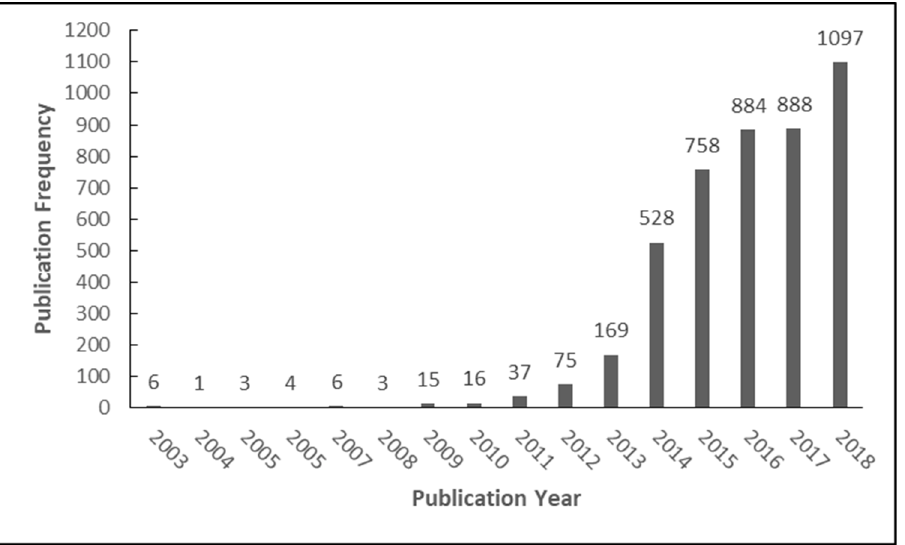
Figure 1. Annual electronic cigarette publication frequency from 2003 to 2018.